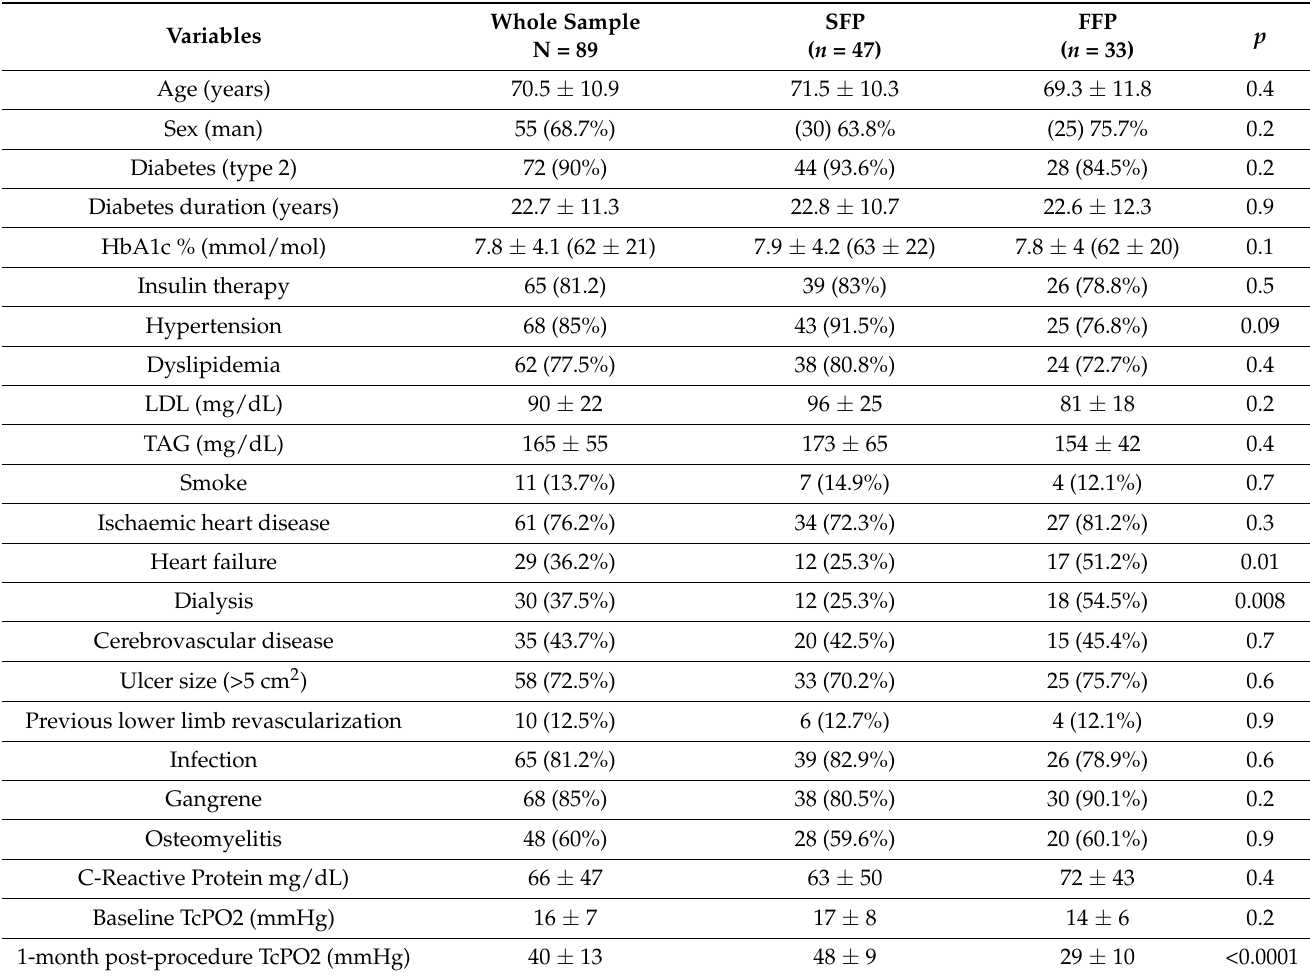
Table 1. Baseline characteristic of whole sample, successful foot perfusion and failed foot perfusion groups. LDL: low- density lipoprotein; TAG: triglycerides; TcPO2: transcutaneous pressure of